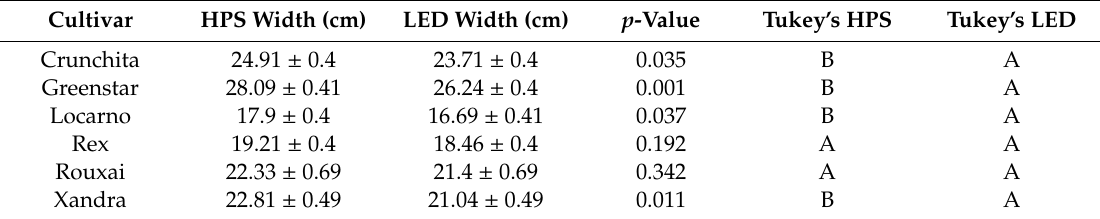
Table12. Diameterofthesixlettucecultivarsinphase2underHPSversusLEDgreenhousesupplemental lights. Data are means ± standard error (SE) of circa 72 plants from three crop cycles. A t -test was used to compare the FW of HPS versus LED within a cultivar ( p -value) and Tukey’s Honestly Significant Di ff erence at α = 0.05 was used to compare cultivars with the HPS or LED treatment. Cultivar HPS Width (cm) LED Width (cm) p -Value Tukey’s HPS Tukey’s LED Crunchita 24.91 ± 0.4